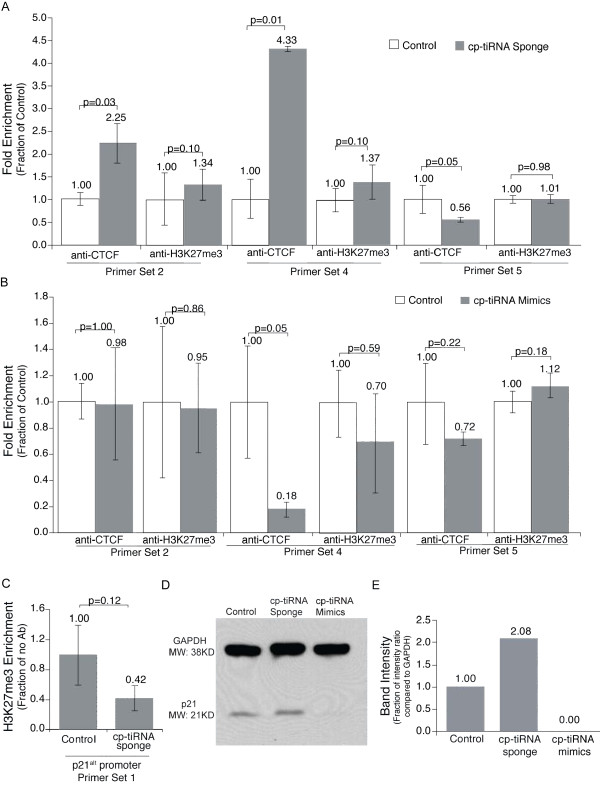
CCCTC-binding factor (CTCF) binding and H3K27 trimethylation (H3K27me3) at p21 (cyclin-dependent kinase inhibitor 1A gene, also known as CDKN1A) in response to the CTCF proximal (cp)-transcription initiation (ti)RNA sponge and mimics. (a) Transfection with the cp-tiRNA sponge resulted in an enrichment of CTCF at the conserved CTCF binding site. H3K27me3 was unaffected at the canonical p21 promoter or in the p21-coding region. (b) Transfection with cp-tiRNA mimics resulted in a decrease of CTCF at the CTCF binding site. H3K27me3 was generally unaffected. (c) Transfection with the cp-tiRNA sponge resulted in a decrease of H3K27me3 at the alternate p21 promoter, consistent with an increase in transcriptional activity. (d) As measured by western blot, samples transfected with the cp-tiRNA sponge showed an increase of p21 protein levels, while samples transfected with the cp-tiRNA mimics showed a decrease. (e) Differences in p21 protein levels from the western blot in (d) quantified using ImageJ. (a-d) Samples were analyzed as indicated 72 h post transfection. No antibody values were subtracted from each immunoprecipitation, and the resultant values were standardized to the input each sample. The averages of samples transfected in triplicate are shown, error bars represent the standard errors of the means, and P values from paired t tests are shown.